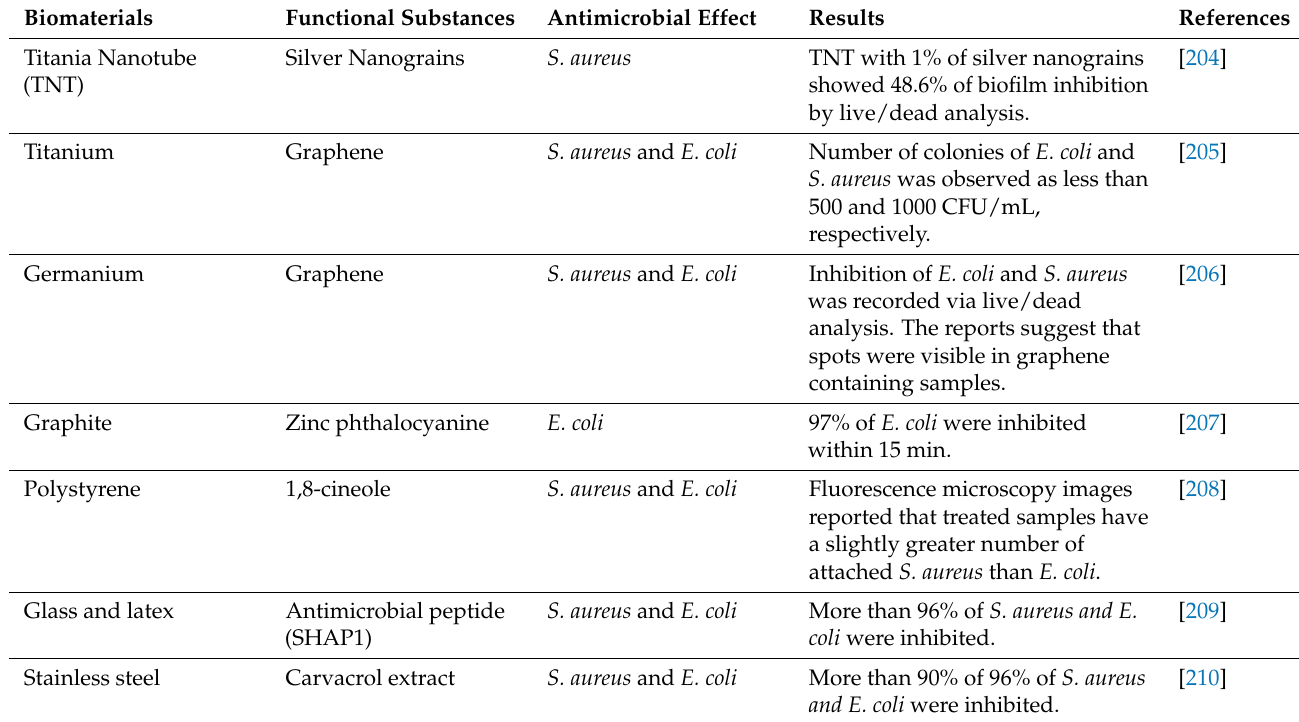
Table 14. Some of the functional agents deposited on biomaterial via the chemical deposition method.